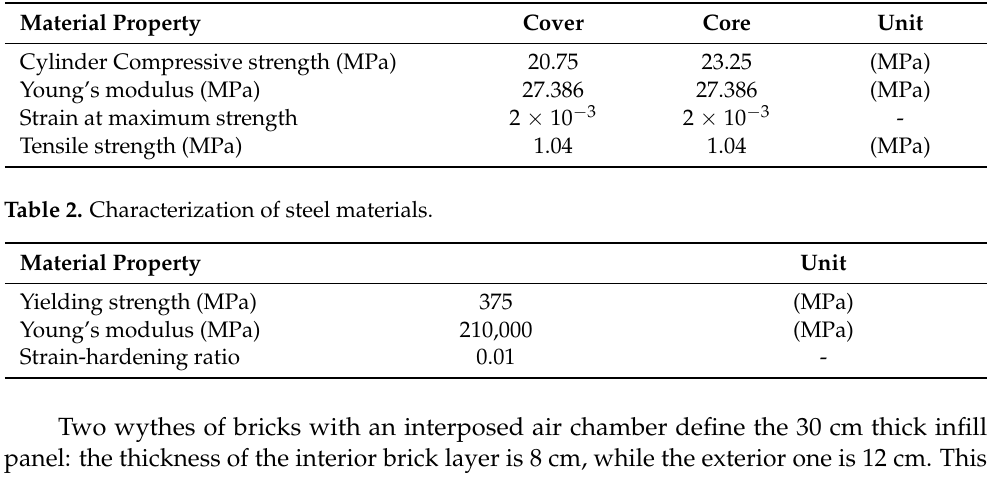
Table 1. Characterization of concrete materials.